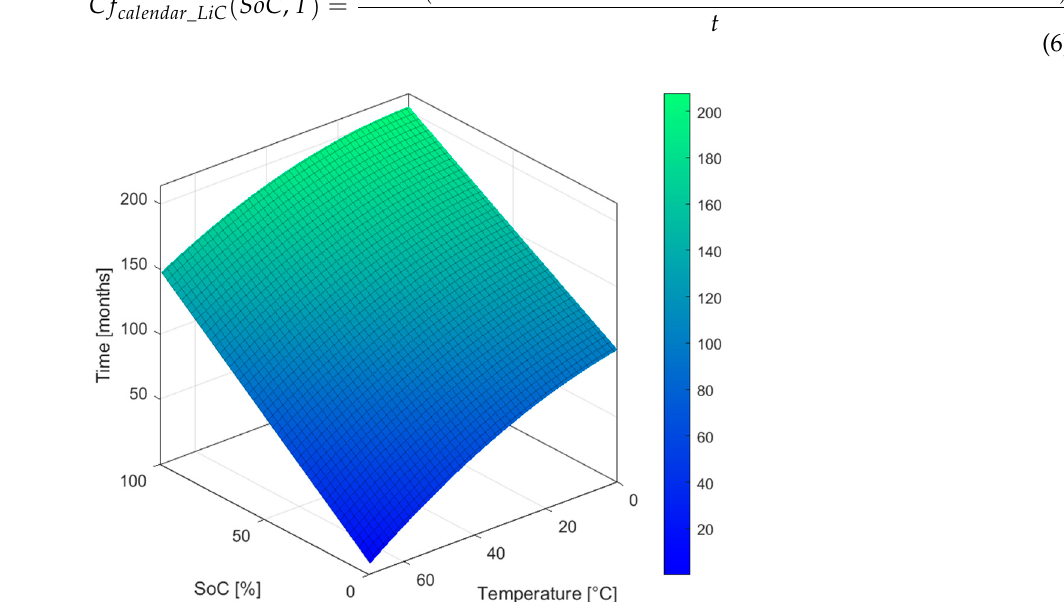
Figure 4. Full equivalent cycles (FEC) of LiB to drop to 80% of beginning-of-life capacity.